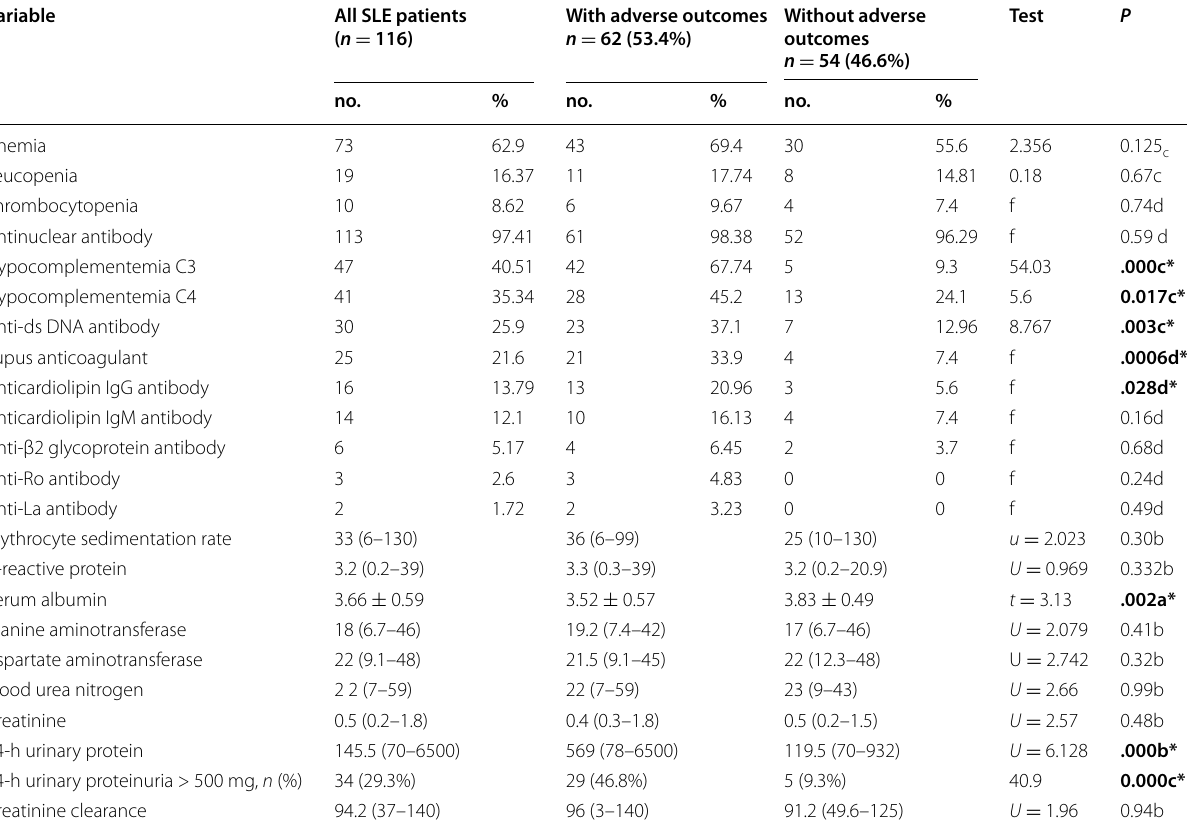
Table 2 Laboratory characteristics of SLE patients at conception according to the occurrence of adverse